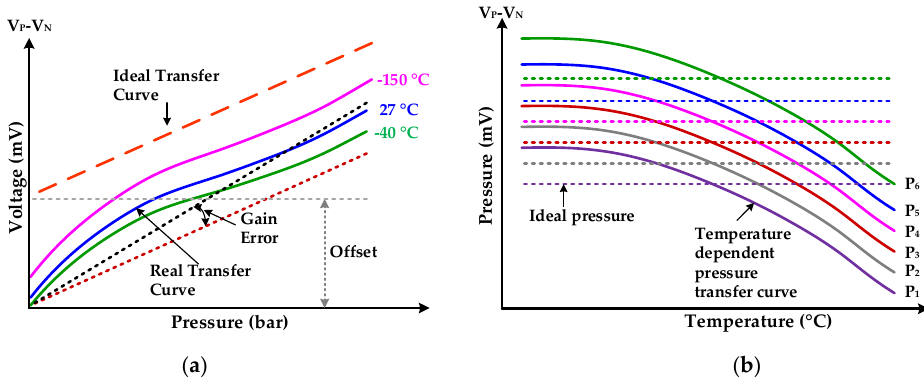
Figure 1. Piezoresistive-type (PRT) sensor transfer characteristics: ( a ) PRT input-output characteristics; ( b ) temperature-dependent pressure transfer curves at different constant pressures.